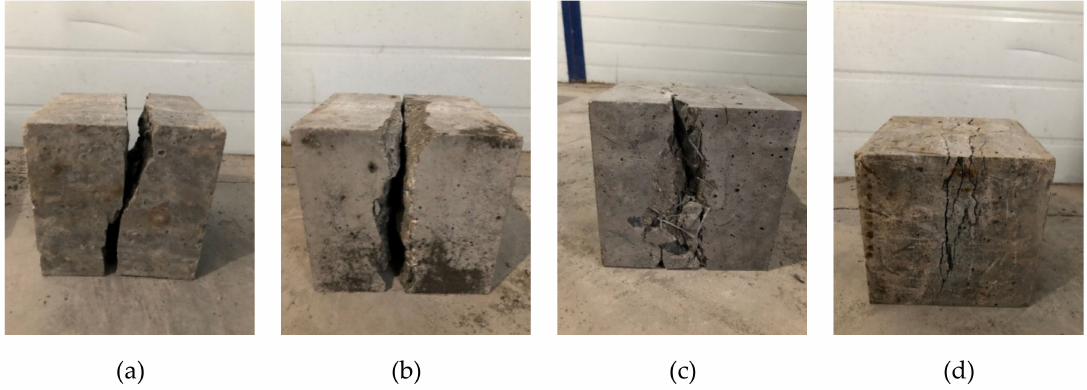
Figure 6. Failure pattern of concrete. ( a ) Reference concrete (RC); ( b ) MgO concrete (MC); ( c ) Steel fiber reinforced concrete (SFRC); ( d ) Steel fiber reinforced MgO concrete